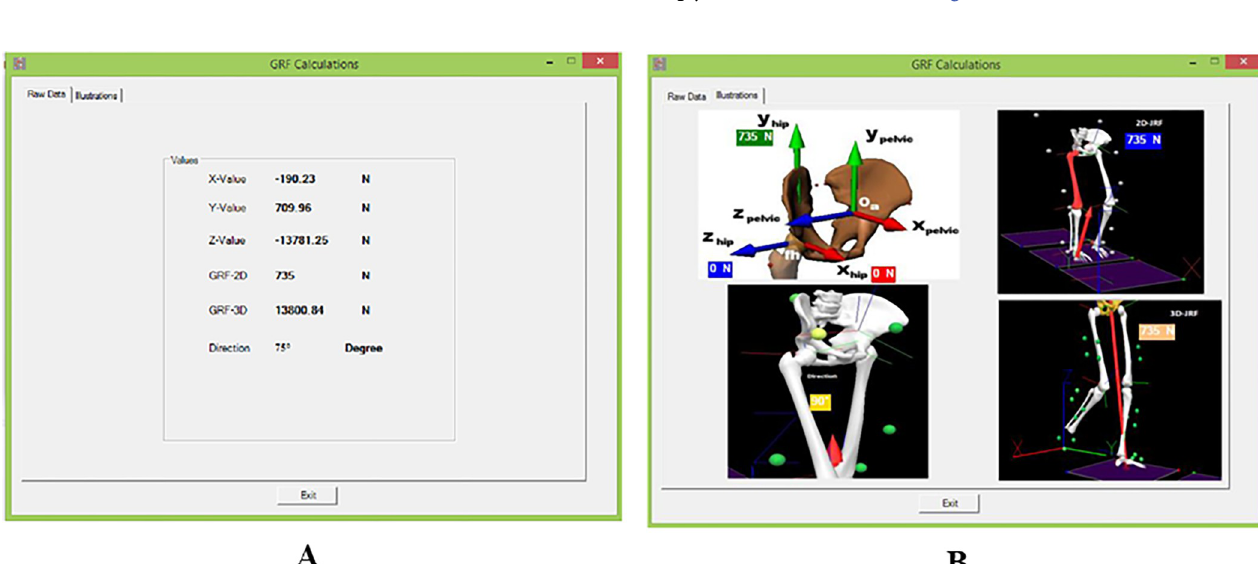
PLOS ONE | https://doi.org/10.1371/journal.pone.0273159 September 26,